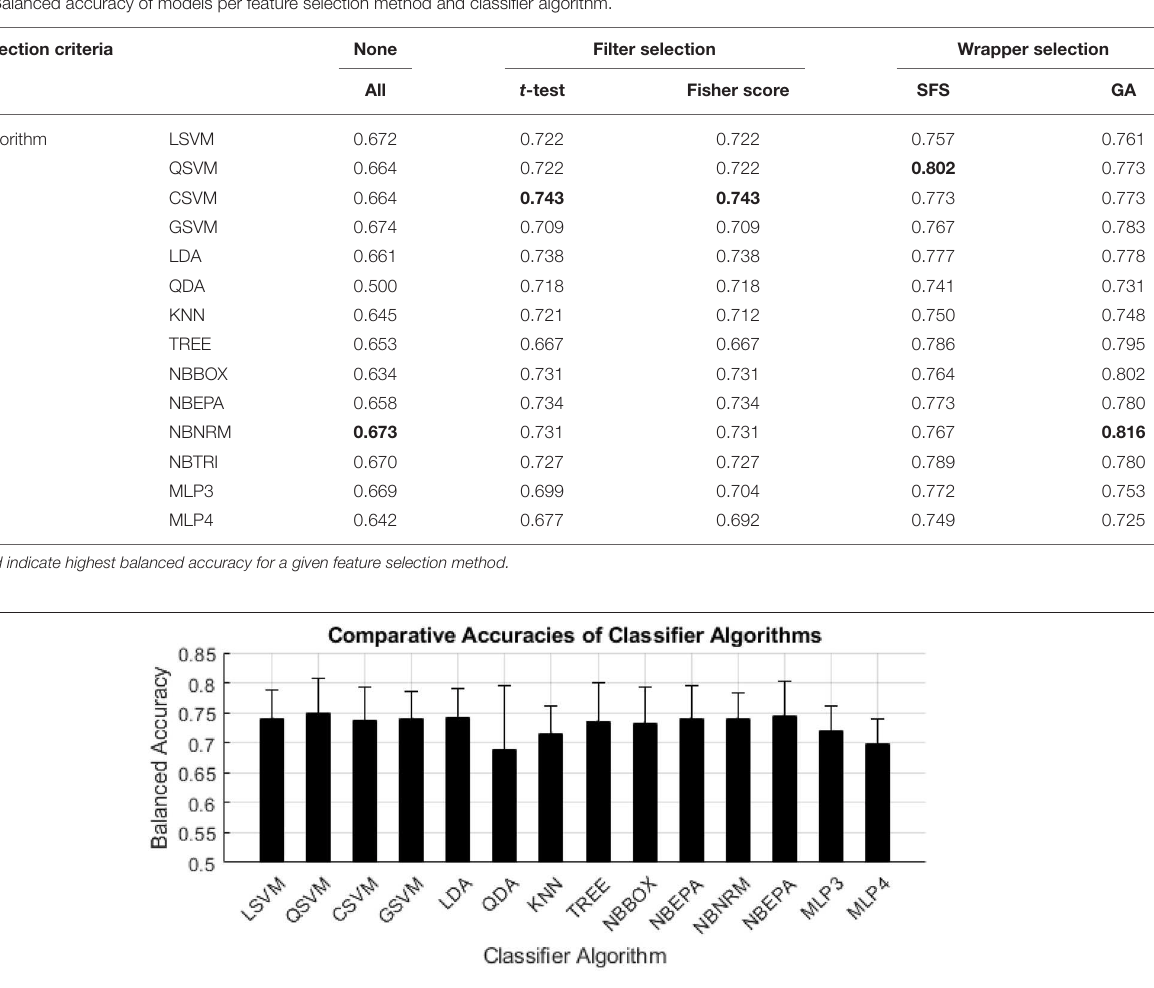
FIGURE 5 | Balanced accuracy per machine learning algorithm. The black bars indicate the mean of the balanced accuracy of each classifier algorithm, the error bars indicate the standard deviation of the balanced accuracy of each classifier